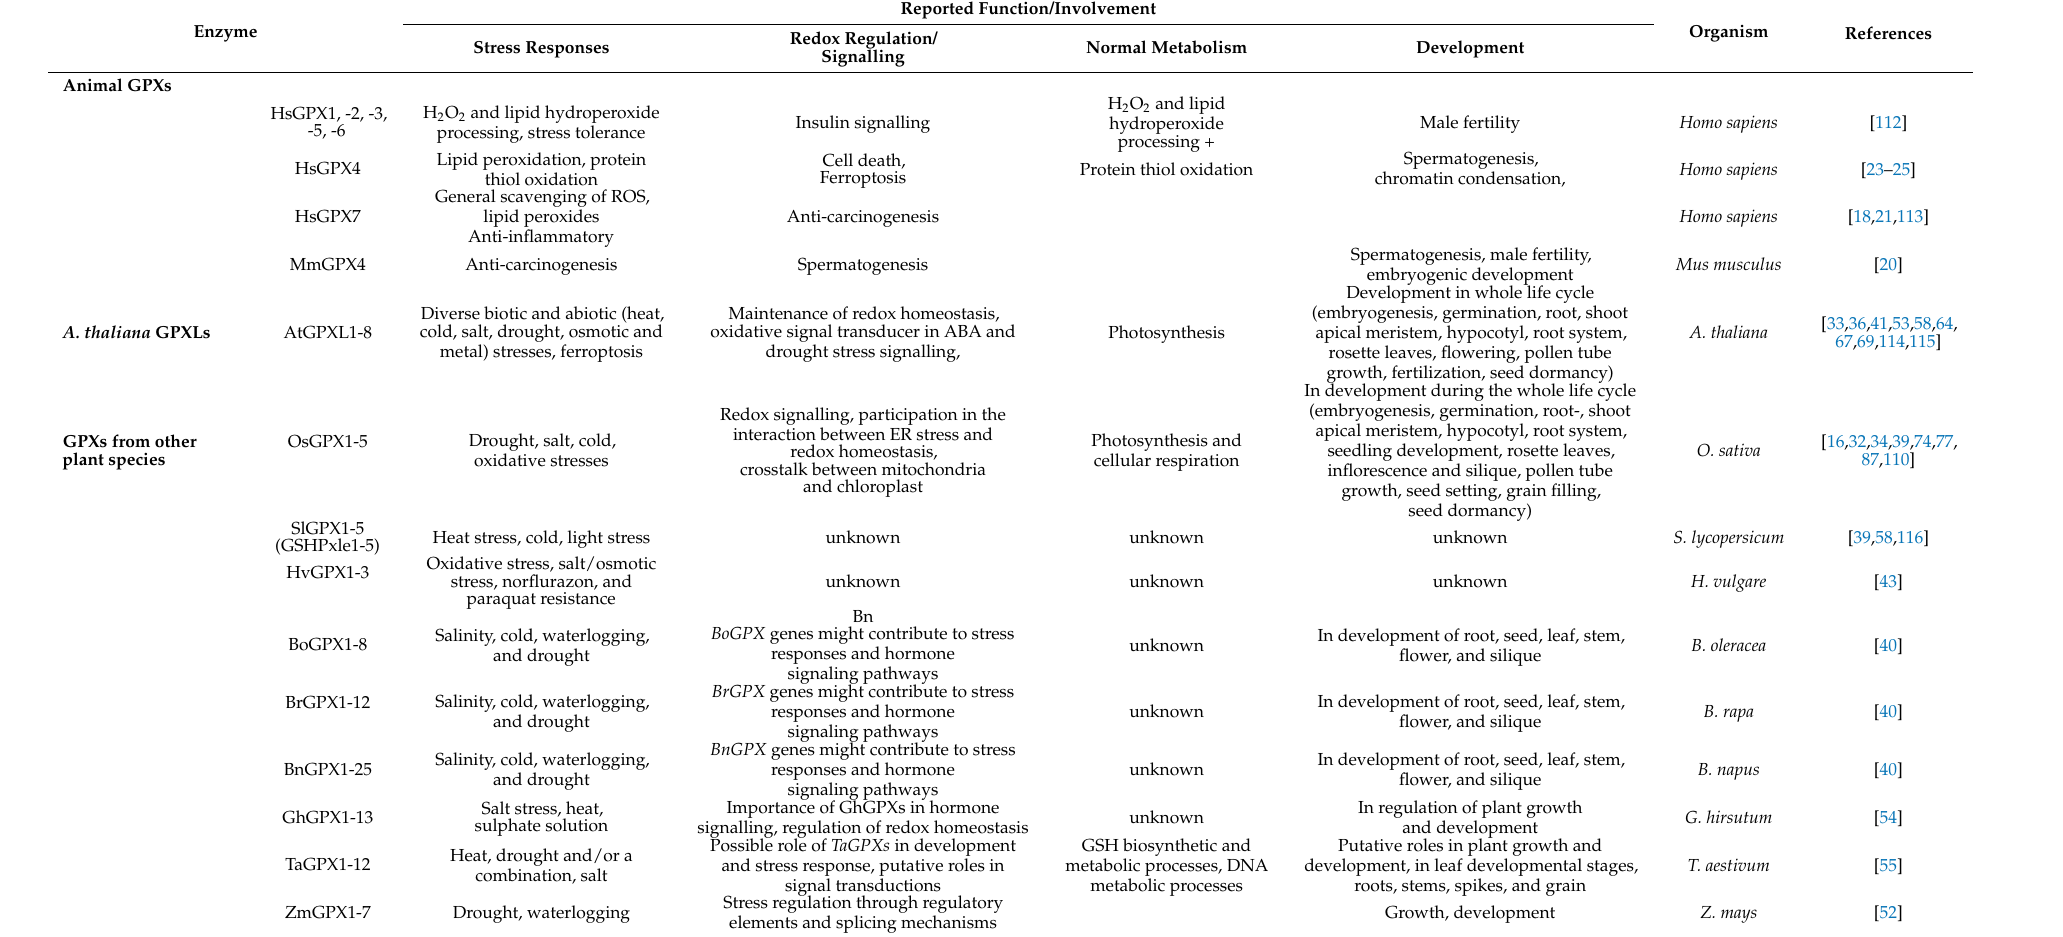
Table 2. Main reported functions of relevant GPXs from different mammalian and plant